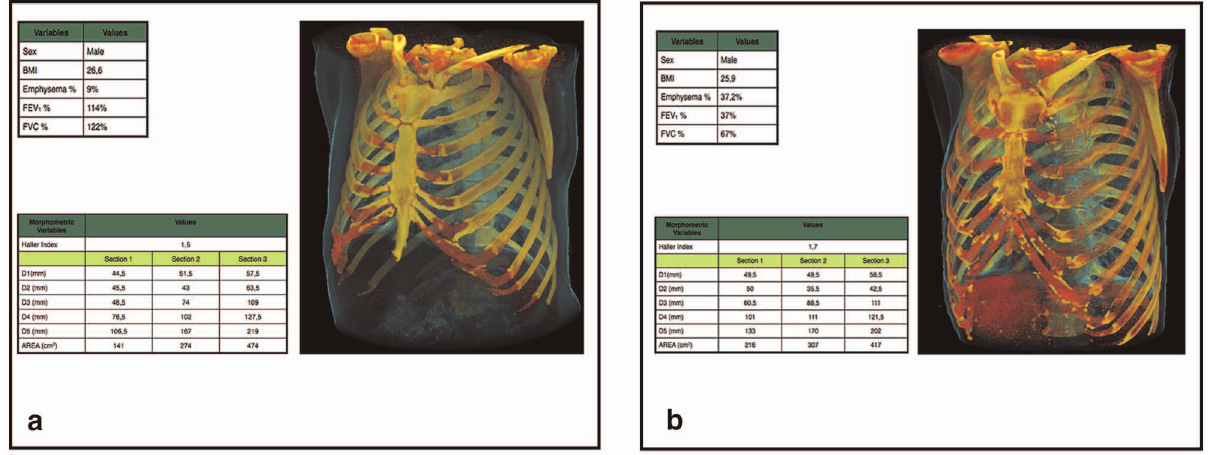
Figure 3. Rib cage morphometric differences between a normal 58-year-old male smoker (A) and a 61-year-old male COPD patient with severe emphysema (B). Both detailed measurements and the 3D reformation display the main morphologic differences: larger upper rib cage dimensions and smaller lower rib cage dimensions in COPD. Overall, the morphometric changes in COPD contribute to the ‘‘barrel chest’’